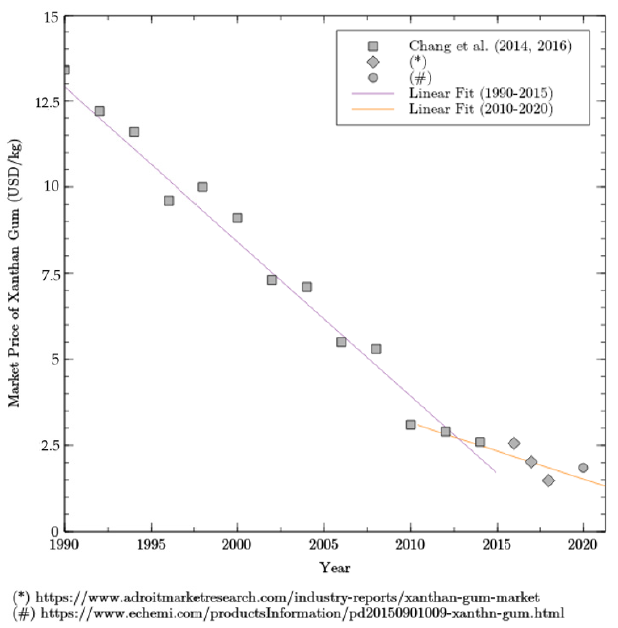
Figure 2. Decrease in the market price of the xanthan gum during the last 30